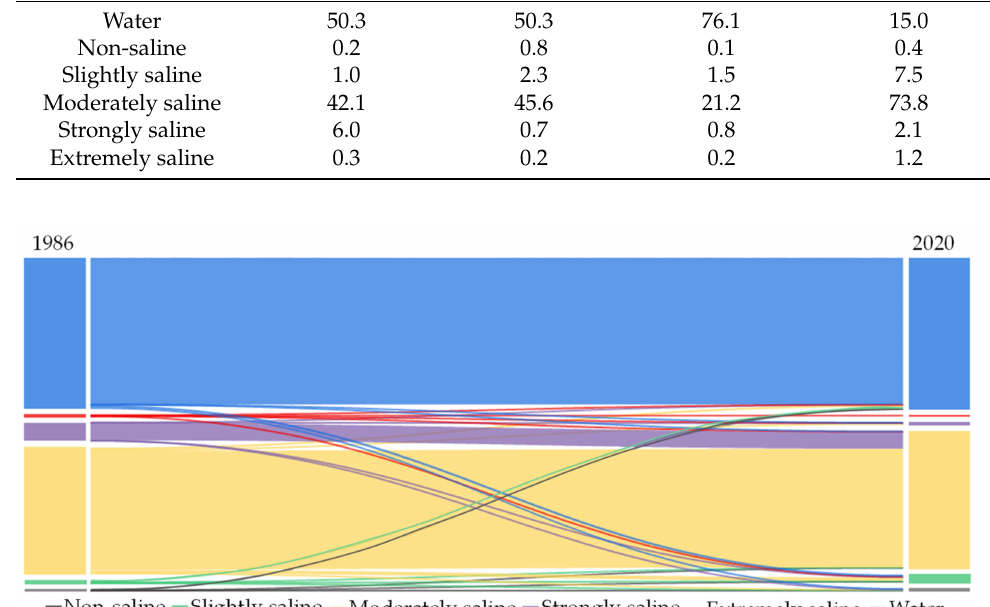
Figure 8. Changes in soil salinity types from 1986 to 2020 in the North Aral Sea.